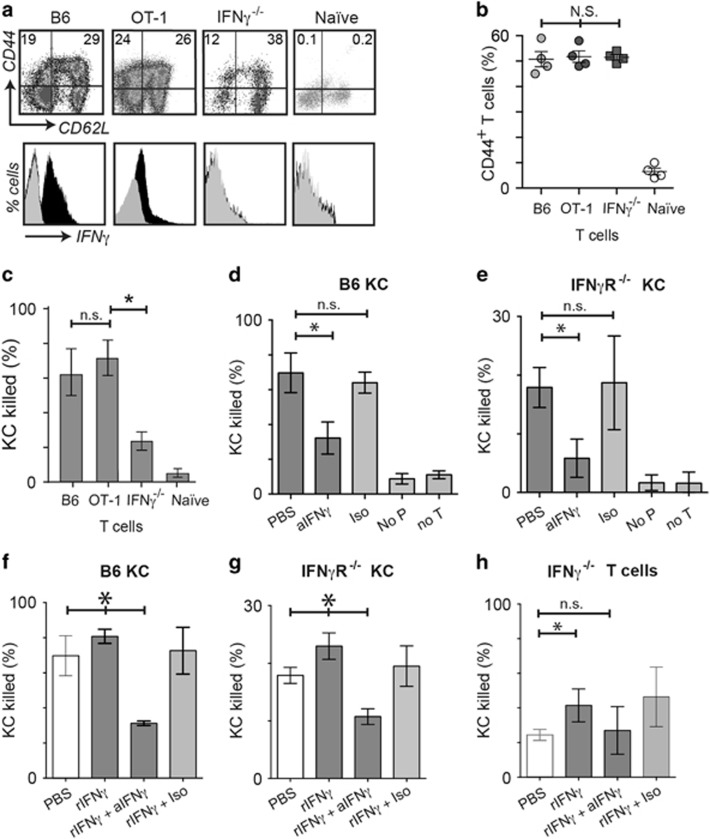
Exogenous IFNγ promotes KC killing by T cells via IFNγ receptor on target cells. (a) Flow cytometry analysis of splenic T cells gated by size, CD8 expression, and EGFP expression, from OVA-immunized OT-I, B6, IFNγ−/−, or OVA-naive B6 mice (black, anti-IFNγ; gray, isotype antibody). N=4. (N.S., not significant between groups, ANOVA.) (b) Percentage of total CD8 T cells from (a) that express CD44. N=4, error bars are SD. (c–h) These cells were co-cultured with SIINFEKL-loaded target keratinocytes derived from B6 (IFNγR+/+) or IFNγR−/− mice in the presence of indicator dye for intracellular activated caspases, and imaged by time-lapse fluorescence microscopy. Target cell death was determined by analyzing movies using software to identify spots based on size (>12 μm) and red fluorescence, and expressed as a percentage of the total number of KC at 30 h. Duplicate wells were averaged, N=4. Error bars are standard deviations. (*P<0.05, ‘NS’, not significant, Mann–Whitney test; *P<0.05, ‘n.s.’, not significant, ANOVA) (d) OT-I CTL were co-cultured with IFNγR+/+ or IFNγR−/− (e) KC. Co-cultures were treated with anti-IFNγ or PBS. Included in each experiment were control wells: with isotype antibody (Iso), without peptide (No P), and without T cells (No T). (f) OT-I CTL were co-cultured with IFNγR+/+ or IFNγR−/− (g) KC and were treated with rIFNγ, or rIFNγ and anti-IFNγ, or rIFNγ and isotype antibody. (h) IFNγ−/− CD8 T cells were co-cultured with SIINFEKL-loaded B6 KC. Cultures were treated with rIFNγ, or rIFNγ and anti-IFNγ, or rIFNγ and isotype antibody